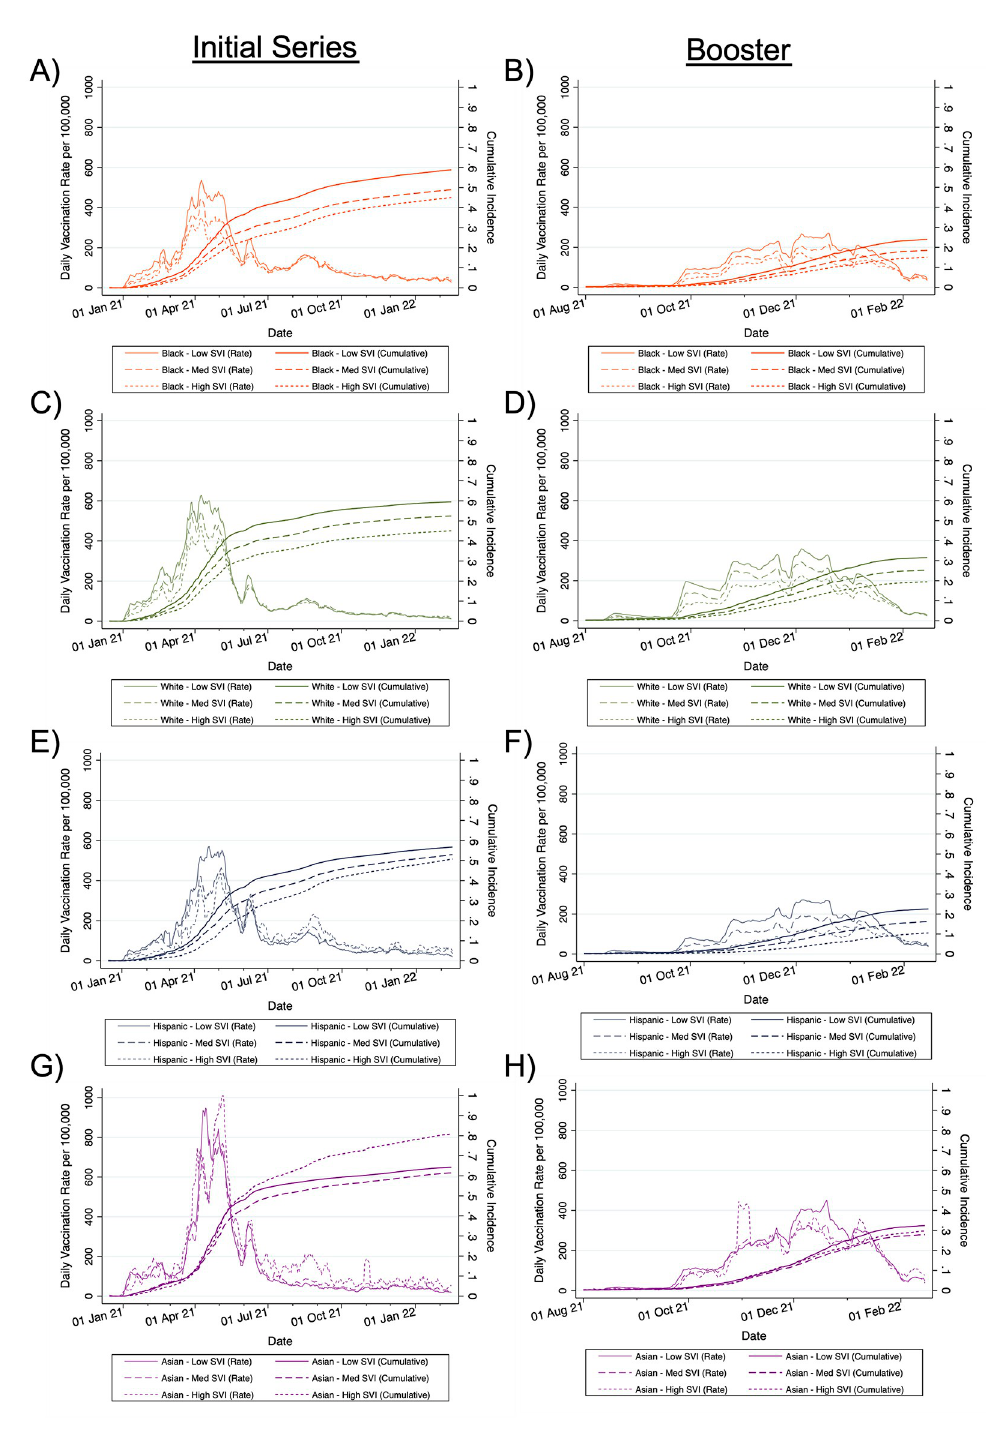
Fig 1. Rates and cumulative incidence of receiving the primary COVID-19 vaccination series and boosters by race/ ethnicity and SVI over time. Initial series and booster vaccinations for Black (A and B), White (C and D), Hispanic (E and F), and Asian (G and H) individuals. Estimates represent 7-day moving averages derived from multiply imputed datasets. Denominators represent the total population aged 12 years and older. Low SVI indicates zip codes with SVI less than 0.333, medium SVI indicates zip codes with SVI between 0.333 and 0.666, and high SVI indicates zip codes with SVI greater than 0.666 AU : InthecaptiontoFig 1 ; forhighSVI ; Ichangedgreaterthanorequalto 0 : 666 togreaterthan 0 : 666 tomatchthedefinitiongivenintheMethods ð andtokeepthebordervalueforhighSVIfromoverlappingwiththebordervalueformediumSVI Þ : Ifthisisnotcorrect ; pleaseeditasnecessary : . SVI, Social Vulnerability Index.